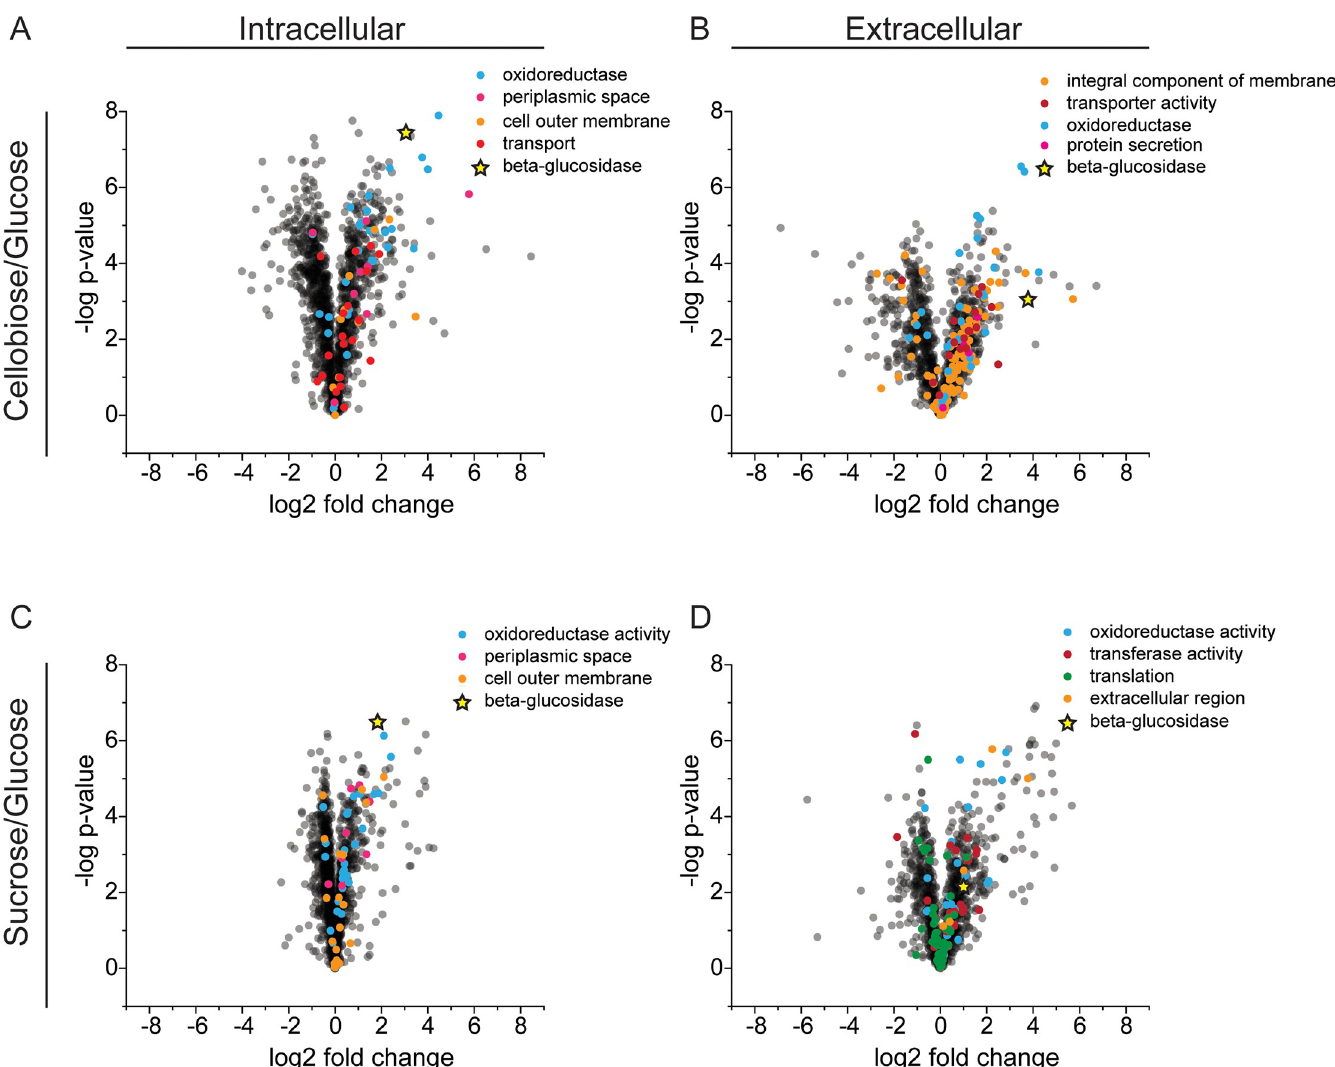
Fig 5. Volcano plots of Gene Ontology (GO) enrichment analysis showing differential expression of GO term proteins. The upper panels show (A) intracellular and (B) extracellular proteomics for cellobiose-adapted Z . mobilis GH3 compared to unadapted strain. The lower panels show (C) intracellular and (D) extracellular proteomics for sucrose-adapted Z . mobilis GH3 compared to unadapted strain. All enriched GO term proteins are indicated with spheres of distinct colors and β - glucosidase upregulation is shown as a yellow star.